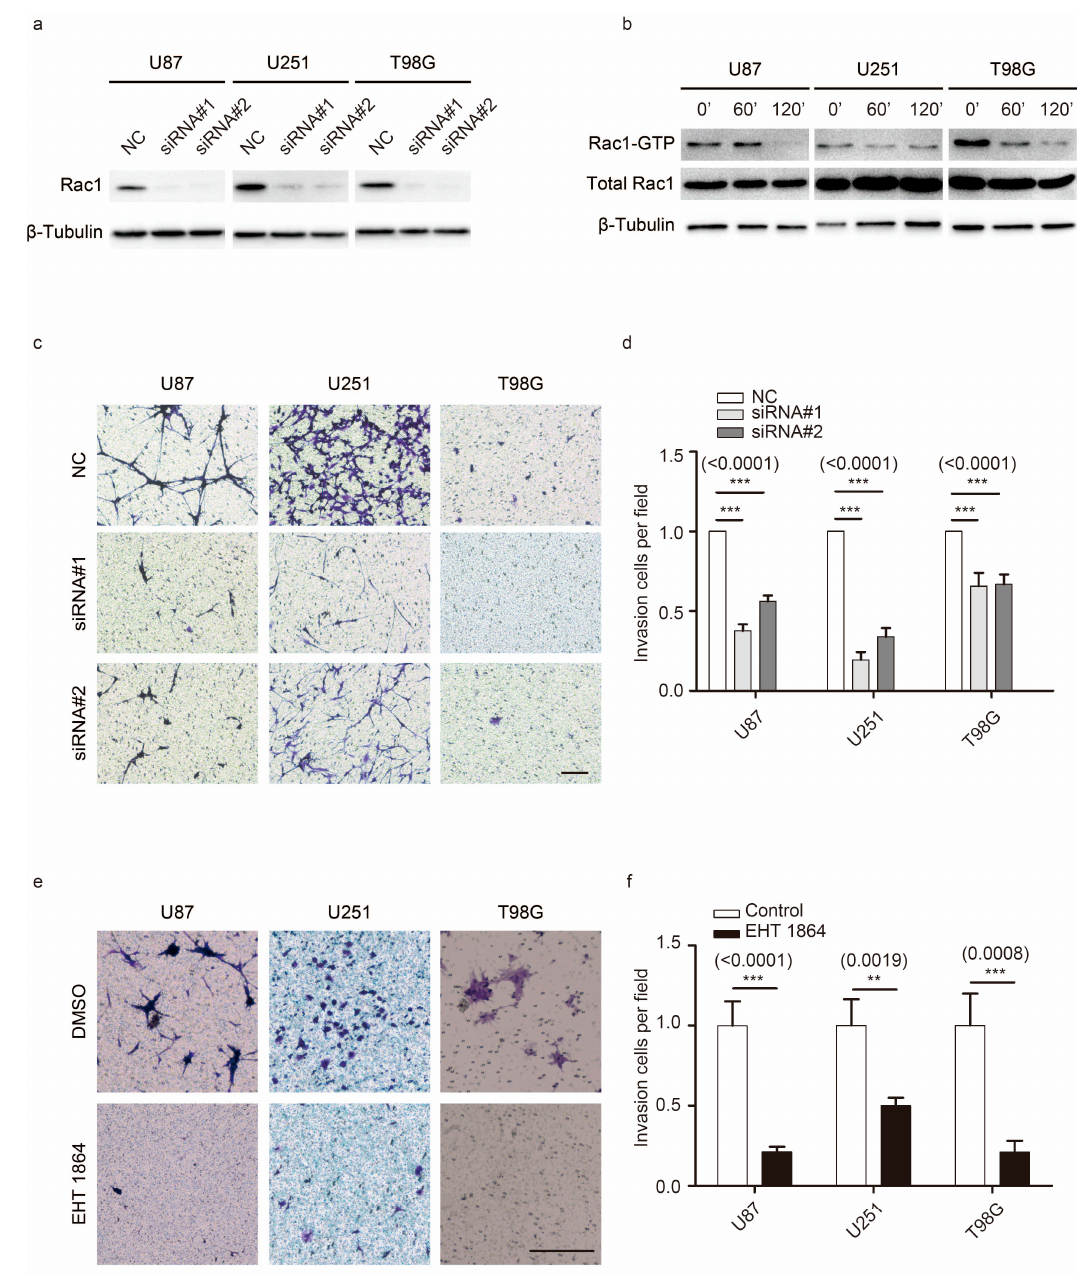
Figure 1. Rac1 is essential for glioblastoma (GBM) invasion. ( a ) Western blot analysis for Rac1 expression in U87, U251, and T98G cells 48 h after treating with siRNAs against Rac1 and negative control (NC).( b ) The levels of Rac1-GTP (upper panel) with or without EHT 1864 treatment for 1 h or 2 h were concentrated by PAK-GST pull down assay and detected by Rac1 antibody. The expressions of total Rac1 protein (middle panel) and β‐ tubulin were also detected. ( c , e ) Invasion trans well assays were carried out to detect the invasion ability of U87, U251, and T98G cells uponRac1 knockdown ( c ) and 10 μ M EHT 1864 treatments ( e ). ( d , f ) Cell invasion ability was calculated by counting the number of cells per field. ***: p < 0.001, **: p < 0.01. Scale bar: 1000 μ m. Uncropped blots are shown in Figure S6.